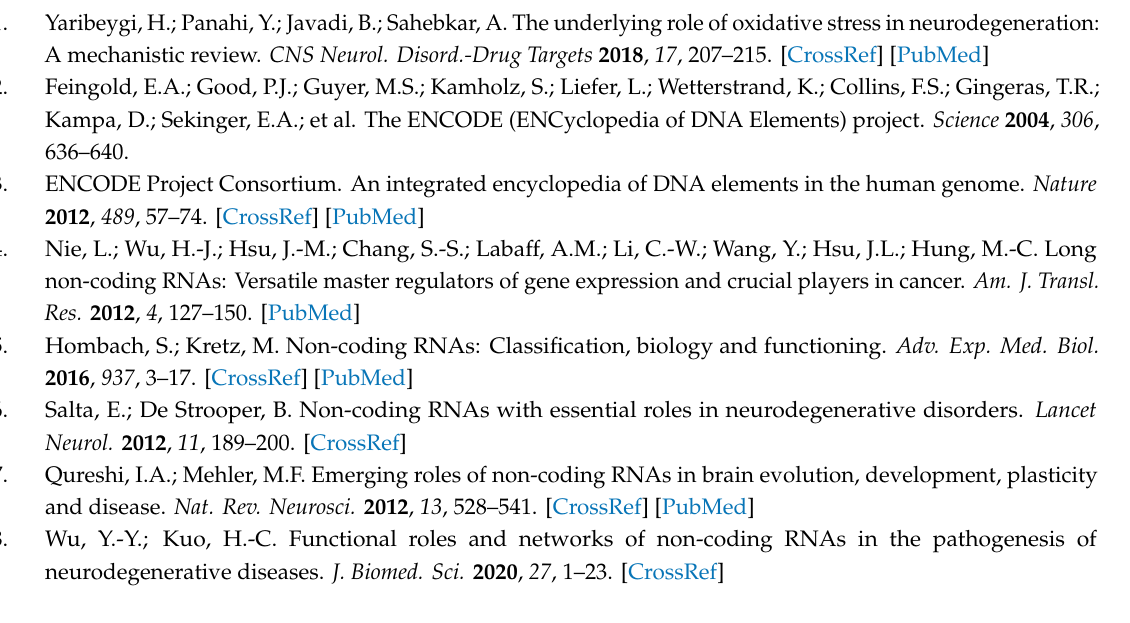
Table S1. List of ncRNAs involved in OS pathways in the context of neurodegenerative conditions. Experimental works proving the involvement of ncRNAs in oxidative stress along AD, PD, HD and ALS are exposed. Author Contributions: A.G.-V. wrote the manuscript, designed both figures and revised the table; A.G.-C., M.H.-L. and M.S.-B. designed and completed the table; and E.M. conceived and wrote the manuscript, and revised both the table and figure design. All authors revised the manuscript prior to submission and approved the final version. All authors have read and agreed to the published version of the manuscript Funding: This work was supported by the Spanish Ministry of Economy and Competitiveness and FEDER funds